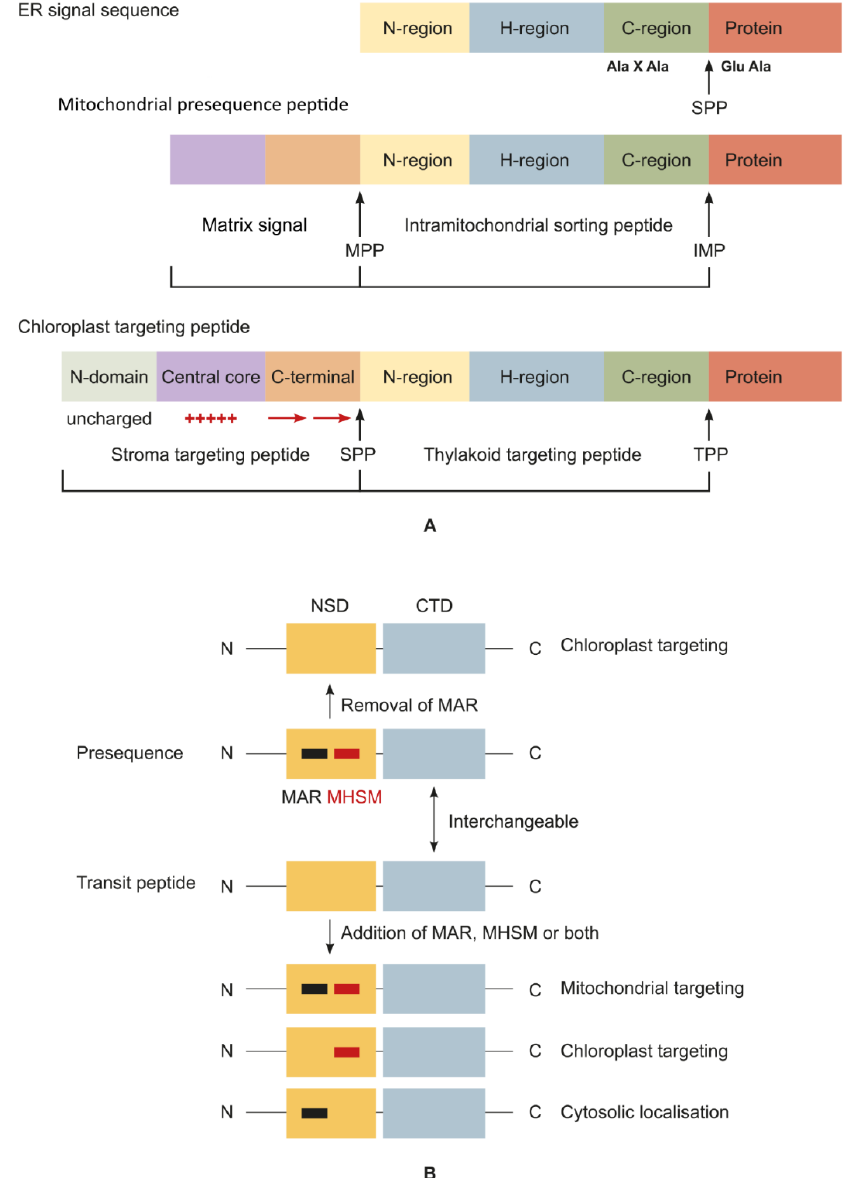
Figure 4. Specific features of the structure of mitochondrial and chloroplast SPs. ( A ) Eukaryotic signal sequences depending on the target organelle: the ER SP has a common tripartite structure; the mitochondrial-targeting peptide is composed of a matrix signal and intramitochondrial sorting signal; and the chloroplast transit peptide comprises the stroma-targeting peptide and thylakoid-targeting peptide. The intramitochondrial sorting signal and thylakoid-sorting signal share a common tripartite structure. Upward arrows denote the cleavage site, and the horizontal arrow denotes a β -sheet (adapted from [19], with permission). ( B ) The relation between the chloroplast transit peptide and mitochondrial presequence. The N-terminal specificity domain (NSD) of mitochondrial presequences contains multiple arginine residues (MAR) and a moderately hydrophobic sequence motif (MHSM). The removal of the MAR is sufficient to switch the targeting specificity from mitochondria to chloro- plasts. Conversely, the incorporation of both the MAR and MHSM into the NSD of chloroplast transit peptides changes the targeting specificity from chloroplasts to mitochondria. The insertion of the MAR or MHSM alone into a transit peptide results in cytosolic localization or chloroplast targeting, respectively. C-terminal translocation domains (CTDs) are interchangeable between these targeting signals (adapted from [170], with